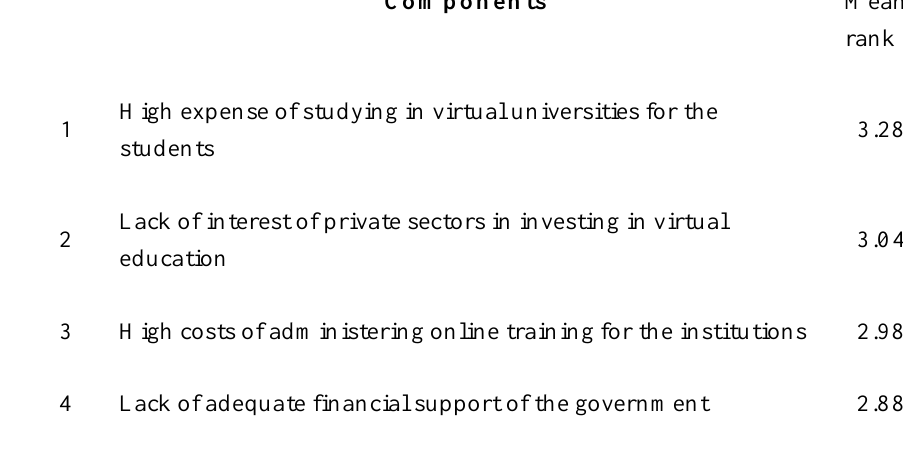
Ranking of the Four Components within the Economic